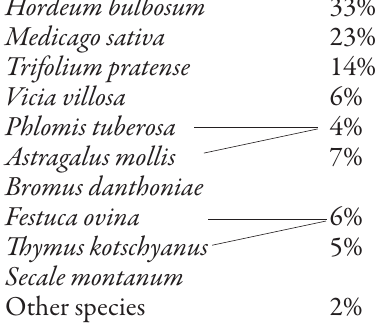
Fig. 2. Slopes facing map of study